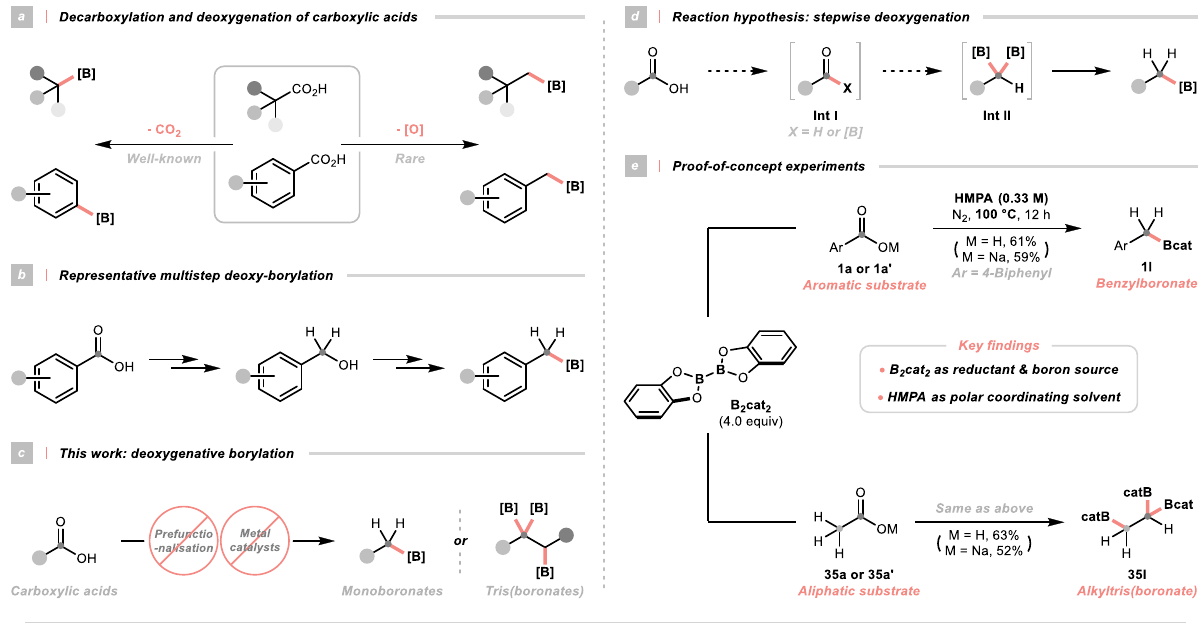
Fig. 1 Introduction. a Decarboxylation and deoxygenation of carboxylic acid; b Representative multistep deoxy-borylation; c This work: deoxygenative borylation; d Reaction hypothesis: stepwise deoxygenation; e Proof-of-concept experiments. For detailed conditions, see Supplementary Information. Yields were determined by NMR. [O], oxygenous functionality; [B], boron-containing functionality; TM transition metal, B 2 cat 2 bis(catecholato)diboron, HMPA